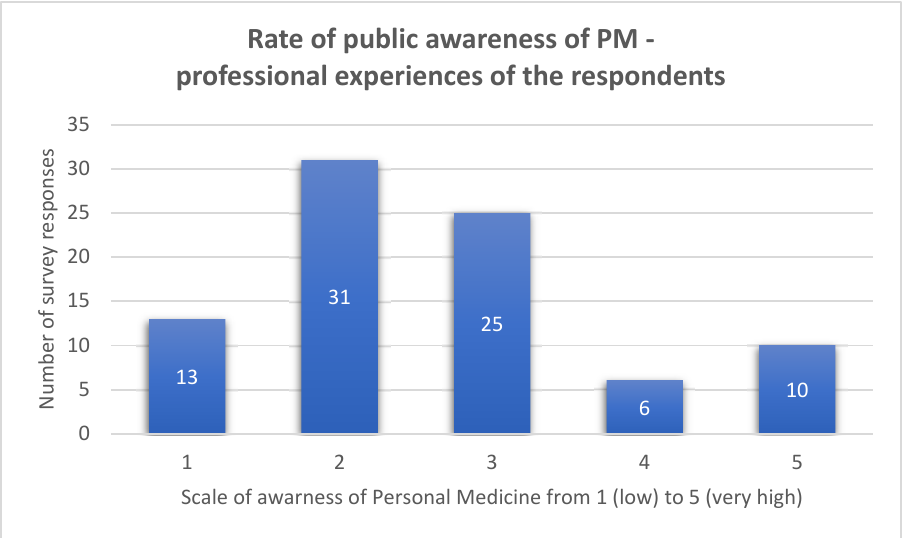
Figure 3. Rate of public awareness of PM—professional experiences of the respondents—break ‐ down by respondents’ nationality (survey data)—bar chart. Below, in the Table 1, the authors have presented the comparison of the public aware ‐ ness of PM in a particular country of respondents, data about low, middle and high ‐ in ‐ come, and their country’s GDP per capita.